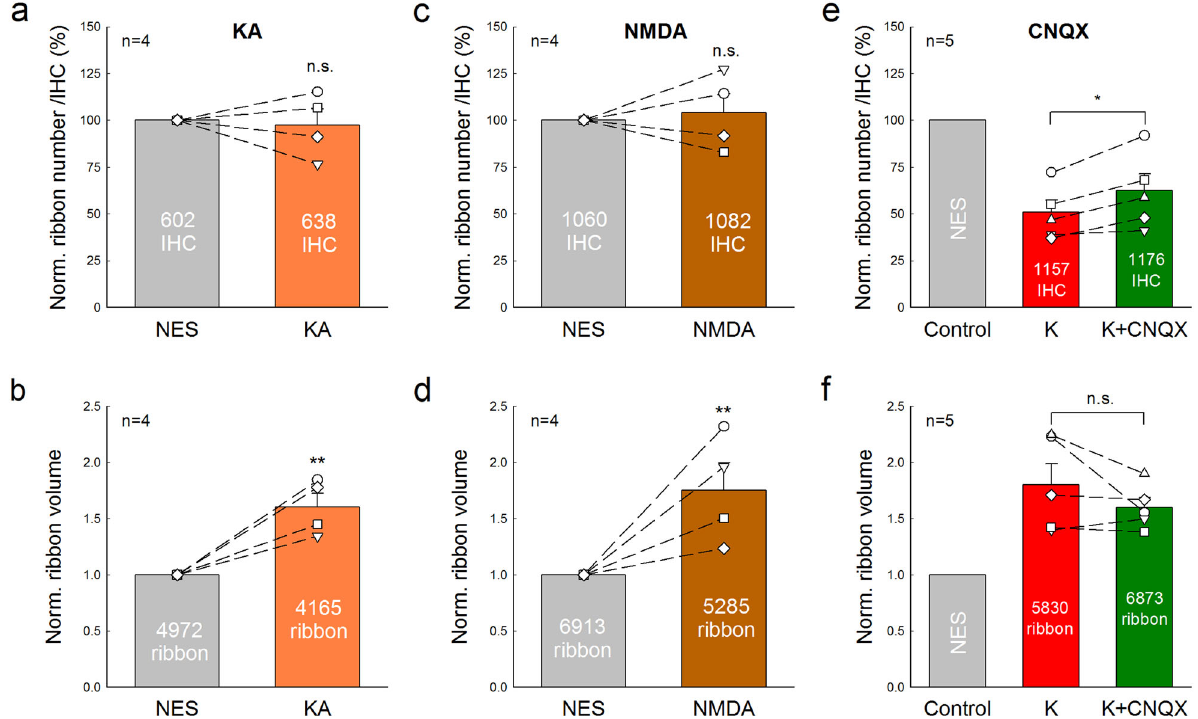
Fig. 7 Effects of GluR agonist and antagonist on IHC ribbon degeneration and swelling. a – d Application of 0.3 mM kainic acid (KA) or 0.3 mM NMDA causes ribbon swelling but not degeneration. The ribbon number and volume pooled from all cochlear turns were averaged and normalized to those in the control cochlea with NES incubation in the same mouse. N is the number of mice. e , f Effects of a GluR antagonist CNQX on K + -induced ribbon degeneration and swelling. One cochlea was incubated in 50 mM K + extracellular solution with 0.1 mM CNQX (K + + CNQX group) and another cochlea of the same mouse was incubated in 50 mM K + extracellular solution (high-K + group). Ribbon numbers and volumes in the high-K + group and the K + + CNQX group were normalized to those in the NES control group in Fig. 1. N is the number of mice. * P < 0.05, ** P < 0.01, and n.s. no signi fi cance ( P > 0.05), paired t -test, two-tail for all